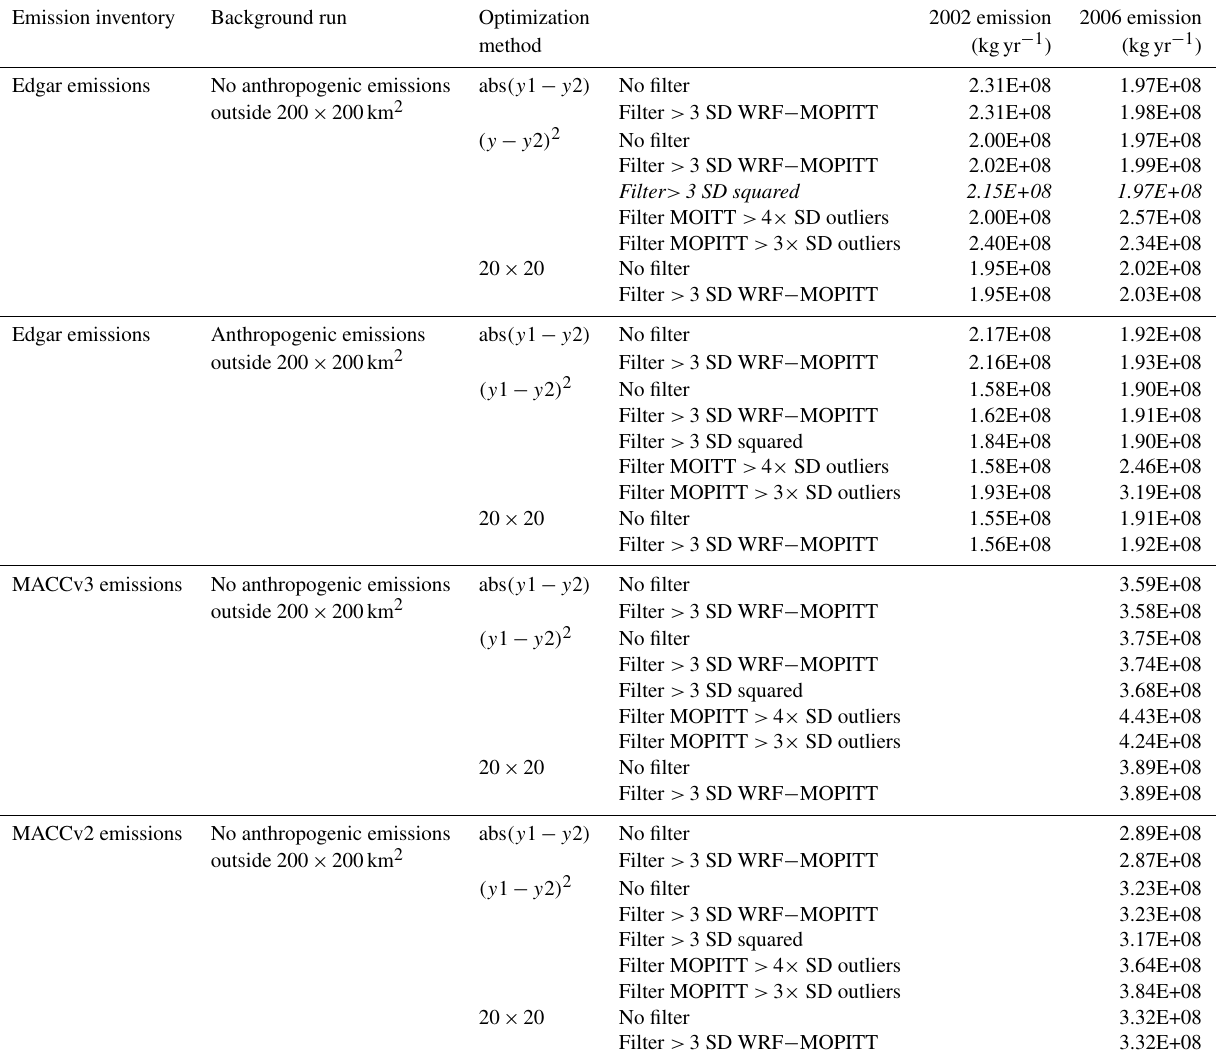
Table 1. Optimization-derived CO emissions comparing different approaches. The results of the default filtering procedure (shown as blue triangles in Fig. 13) are printed in